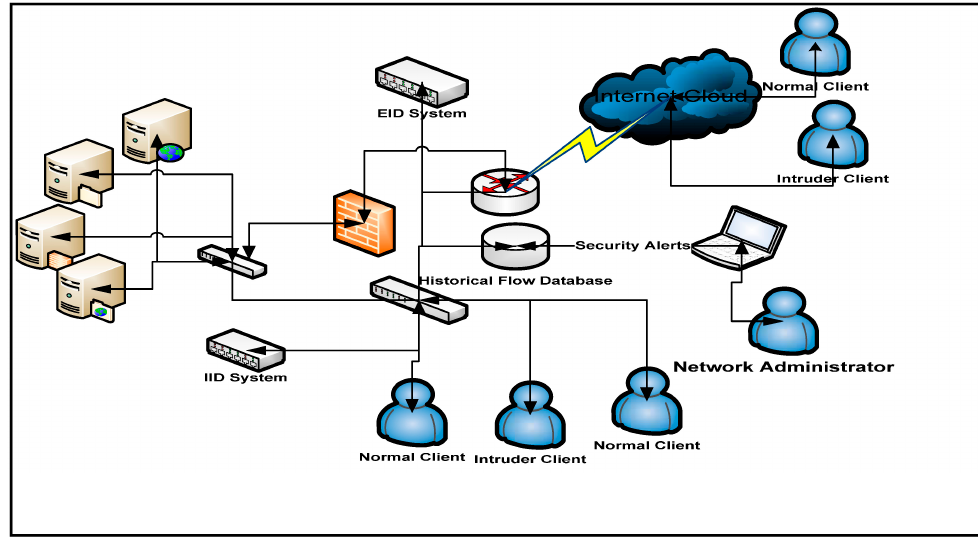
Figure 1. Network Architecture for IDS.